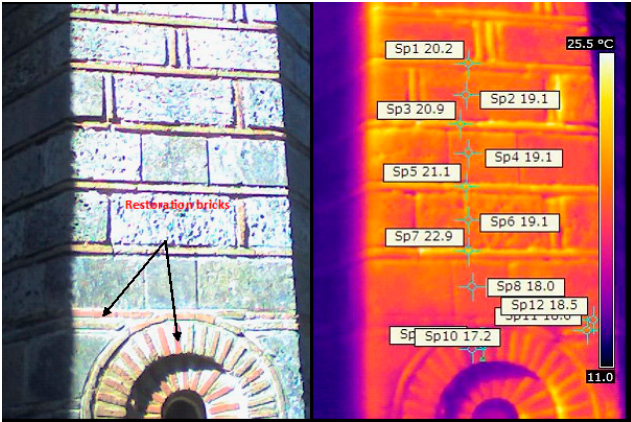
Figure 8. Kaisiariani Monasteri, area of investigation and thermal image.